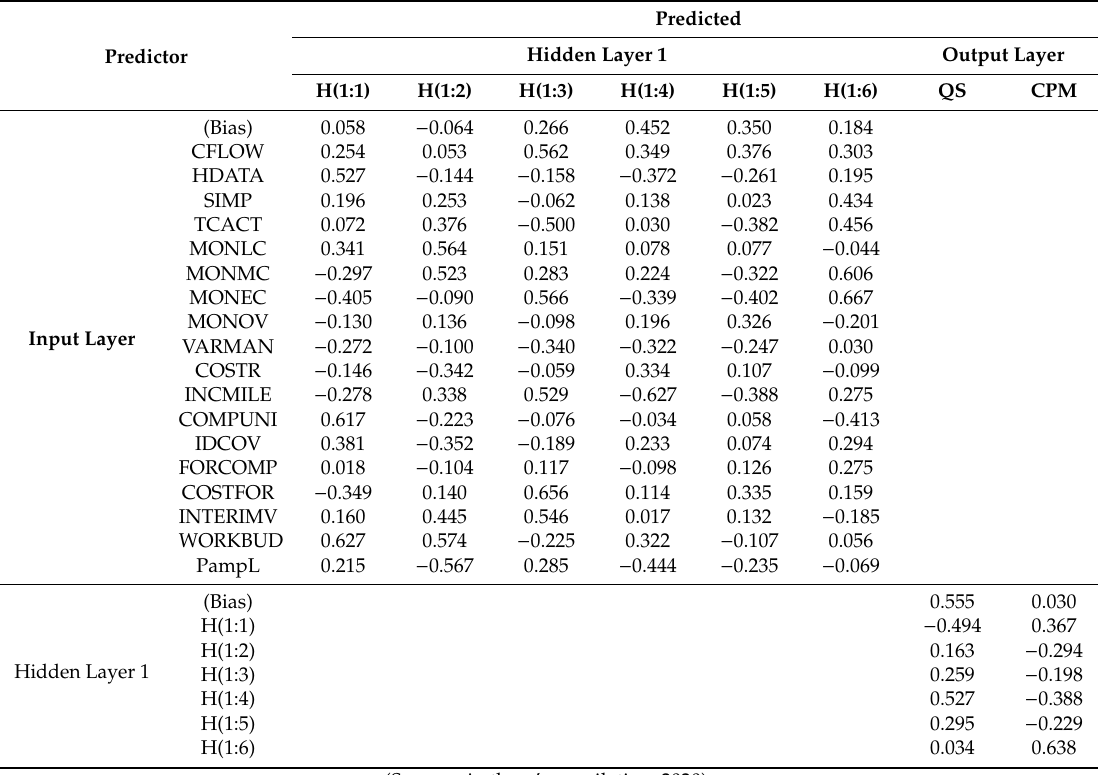
Table 4. Synaptic parameter estimates for level 2.